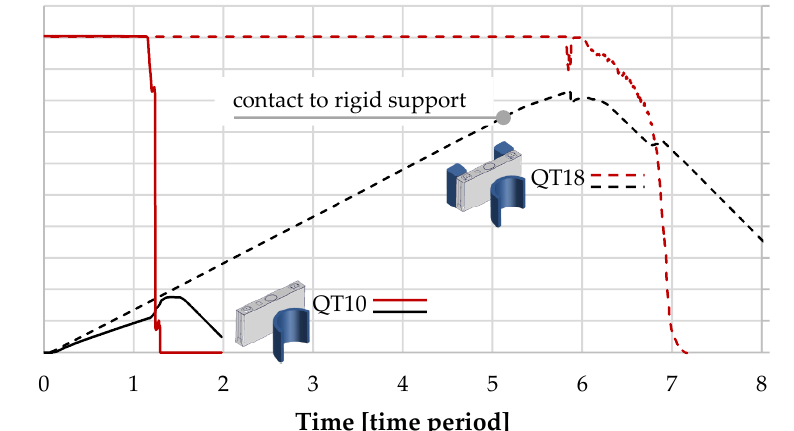
Figure 4. Intrusion and cell voltage over time for two test configurations: QT10—cylindrical impactor with rigid support and QT18—cylindrical impactor with three-point bending.